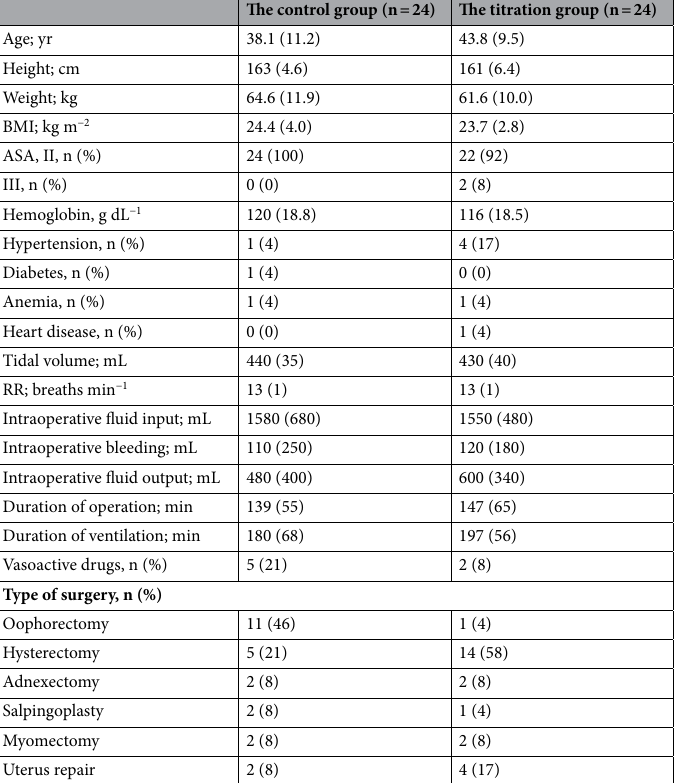
Table 1. Demographics and surgery characteristics. Values are the mean (SD) or number (%). RR respiratory rate; VAS visual analog scale; PPCs postoperative pulmonary complications.